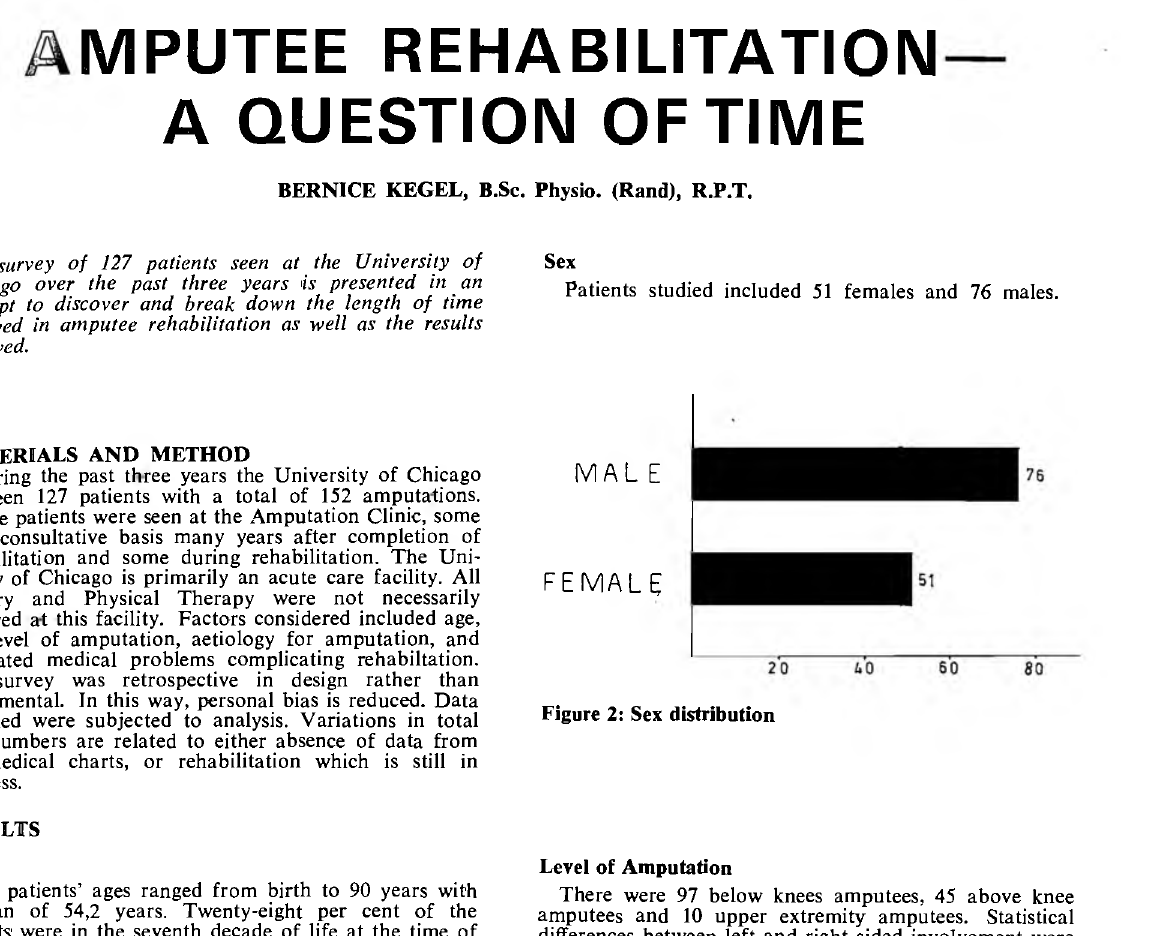
Level of Amputation There were 97 below knees amputees, 45 above knee amputees and 10 upper extremity amputees. Statistical differences between left and right sided involvement were insignificant.